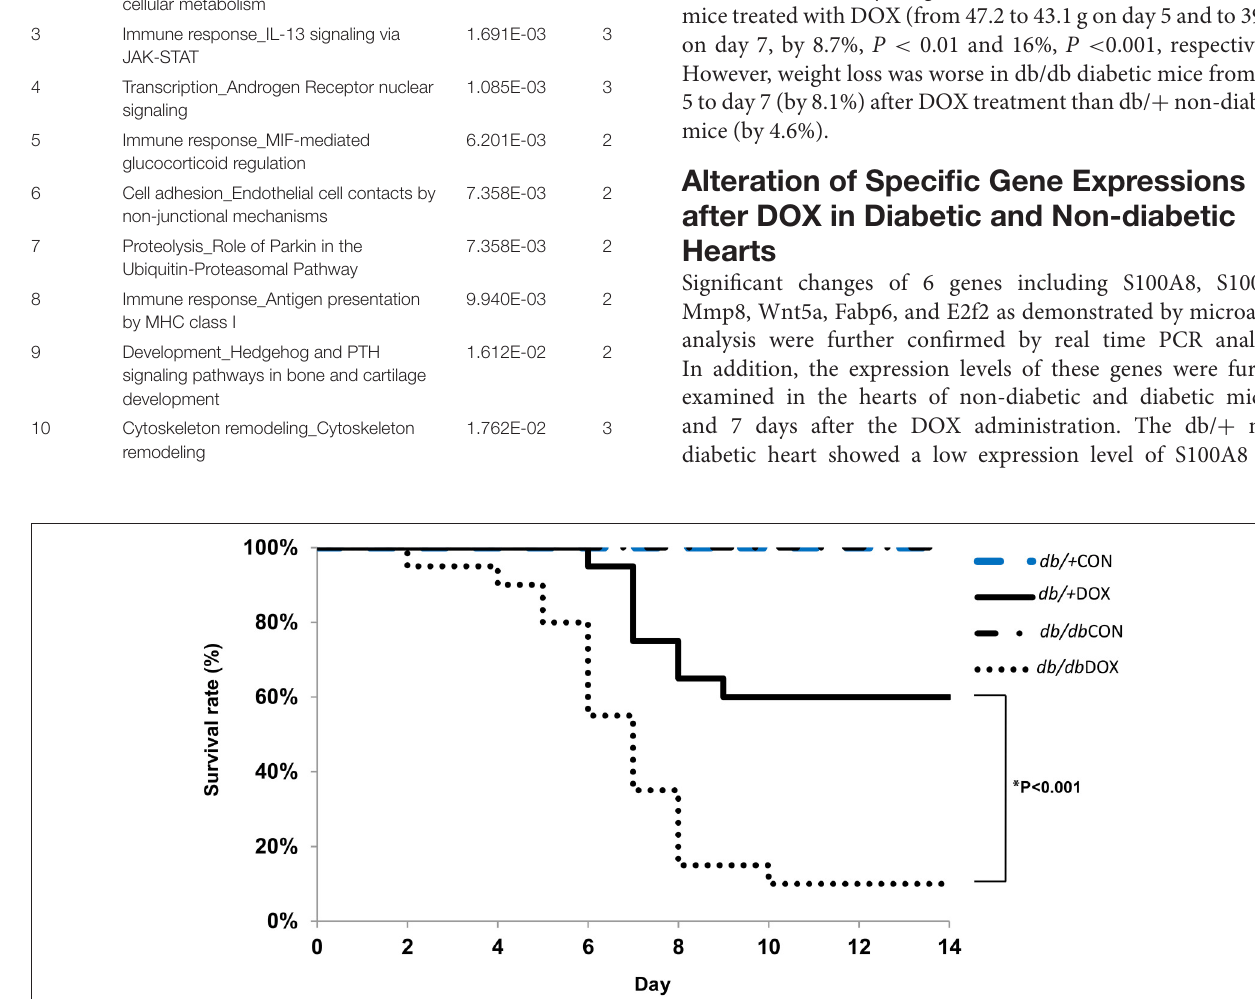
Frontiers in Physiology |